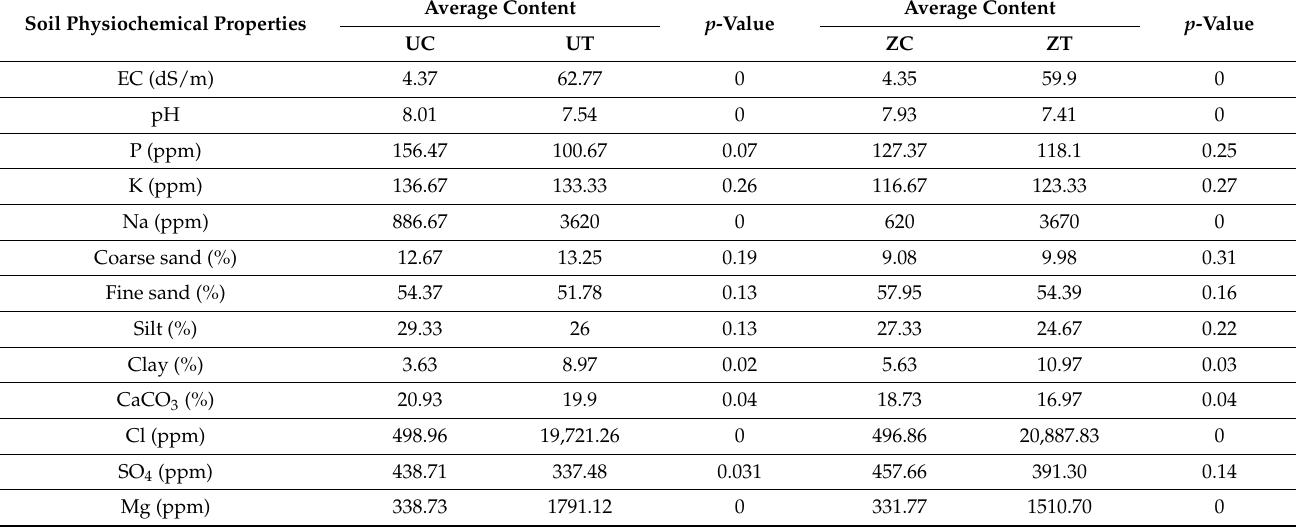
Table 1. Physiochemical properties of the soil used to plant the “Umsila” cultivar under control (UC) and saline (UT) conditions and the “Zabad” cultivar under control (ZC) and saline (ZT) conditions. The statistical analysis was conducted using a t -test; mean ± SD, n =